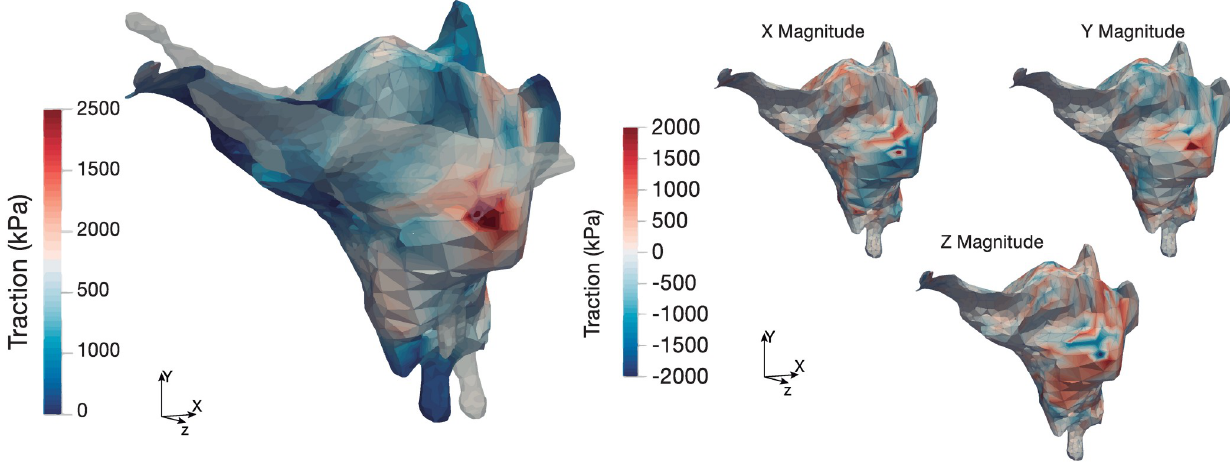
Fig 7. Cell surface traction components (kPa) computed at the cell surface. On the left, cell traction magnitude at the deformed cell surface. Overlaid in white, the undeformed cell configuration. On the right, the three different components of the cell traction forces.